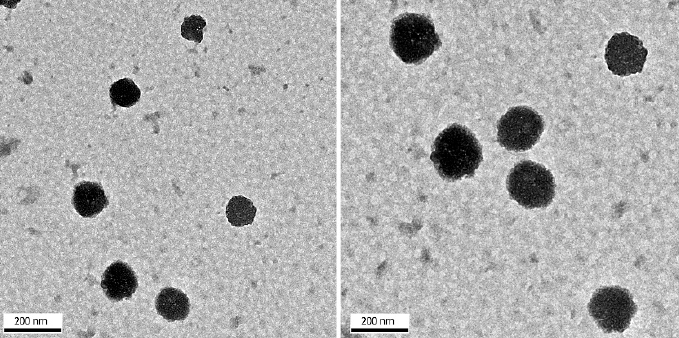
Figure 7. TEM images of PE 607 - b -PLL 275 polymeric micelles at different pH values ( left : pH = 1.5, right : pH = 9.0).